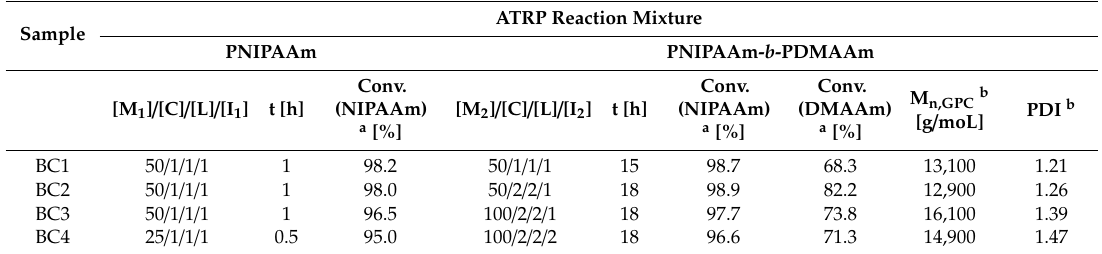
Figure 7. Synthesis of P(NIPAAm- b -DMAAm) block copolymers by the sequential monomer addition approach using the bromine-based ATRP system. Table 6. Polymerization conditions for the synthesis of P(NIPAAm- b -DMAAm) block copolymers by the sequential monomer addition approach using the bromine-based ATRP